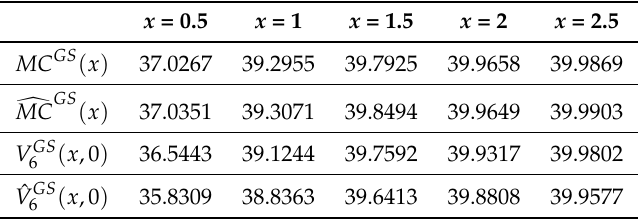
Table 4. Comparison of results obtained via different approaches.